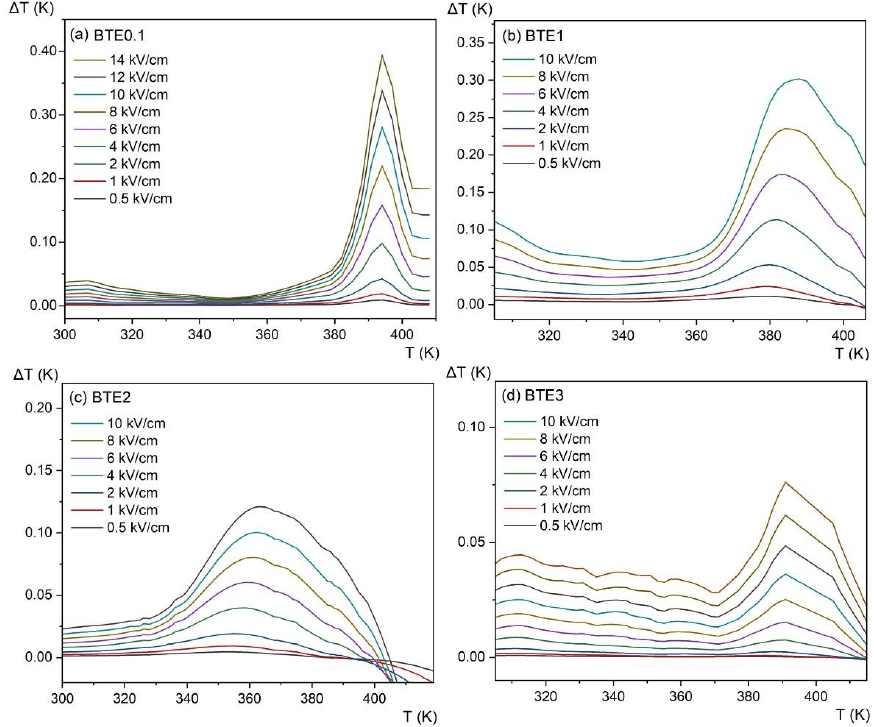
Figure 12. Electrocaloric temperature change ( Δ T) as a function of temperature at different applied fields for BTEx ceramics: ( a ) BET0.1, ( b ) BTE1, ( c ) BTE2, and ( d ) BTE3.